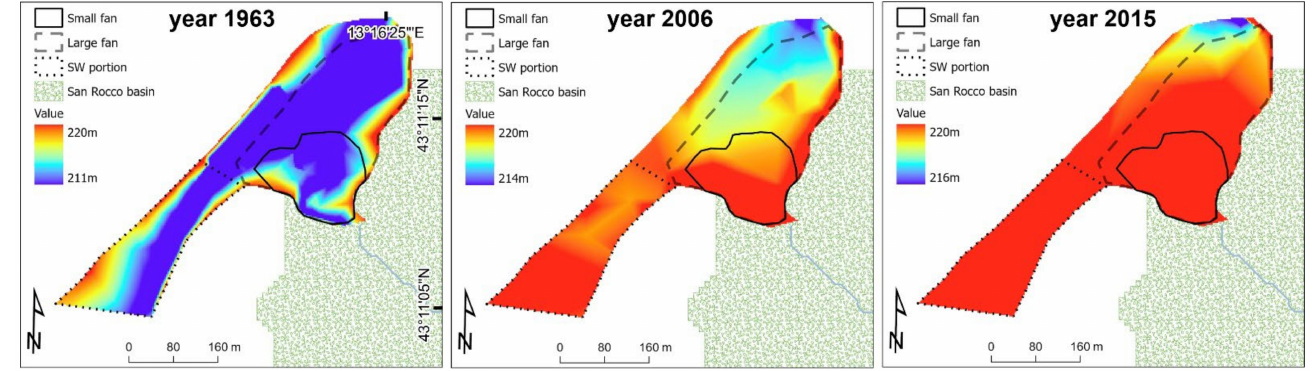
Figure 7. Progressive filling of sediments of Le Grazie reservoir in the period 1963–2015; two fan-like morphologies result evident in the SE portion of the